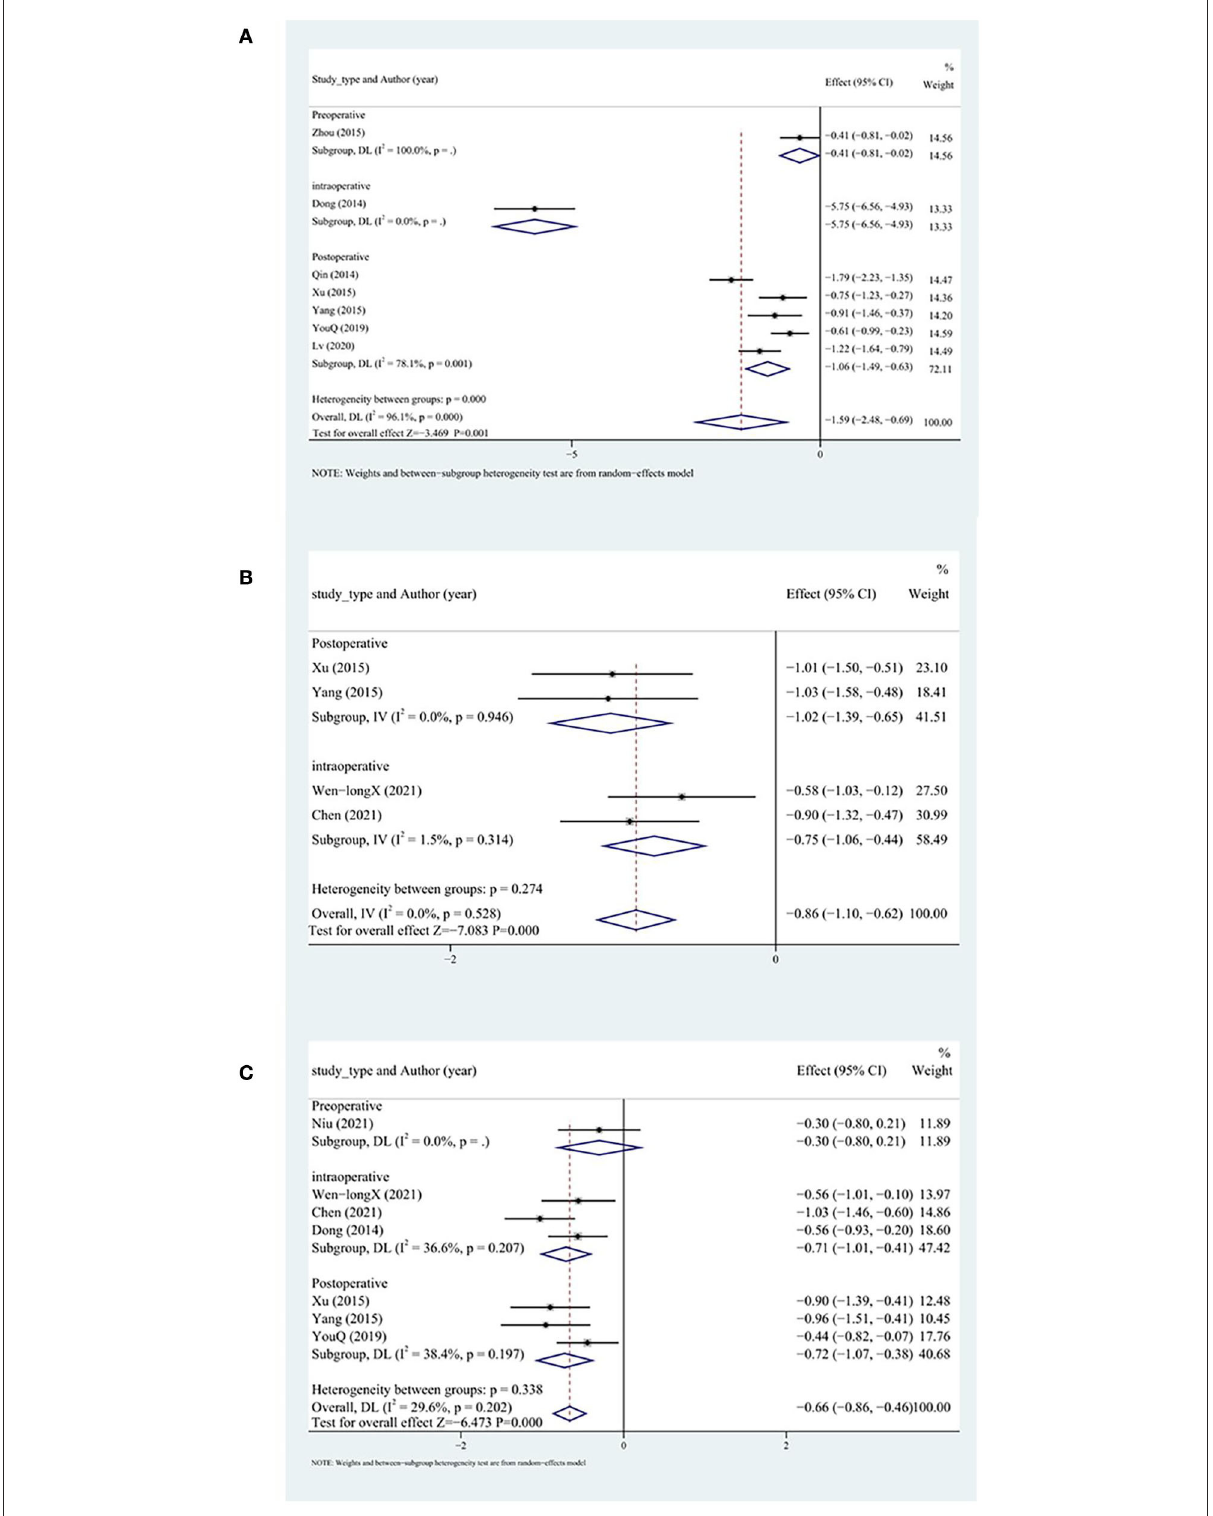
FIGURE7 Myocardial injury index subgroup analysis including (A) cTnT, (B) CK, and (C) CK-MB. cTnT, cardiac troponin T; CK, creatine